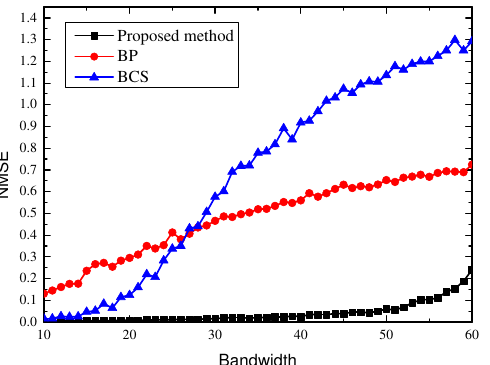
Figure 5. NMSE of graph signal (GS) estimation of different algorithms under different bandwidths.